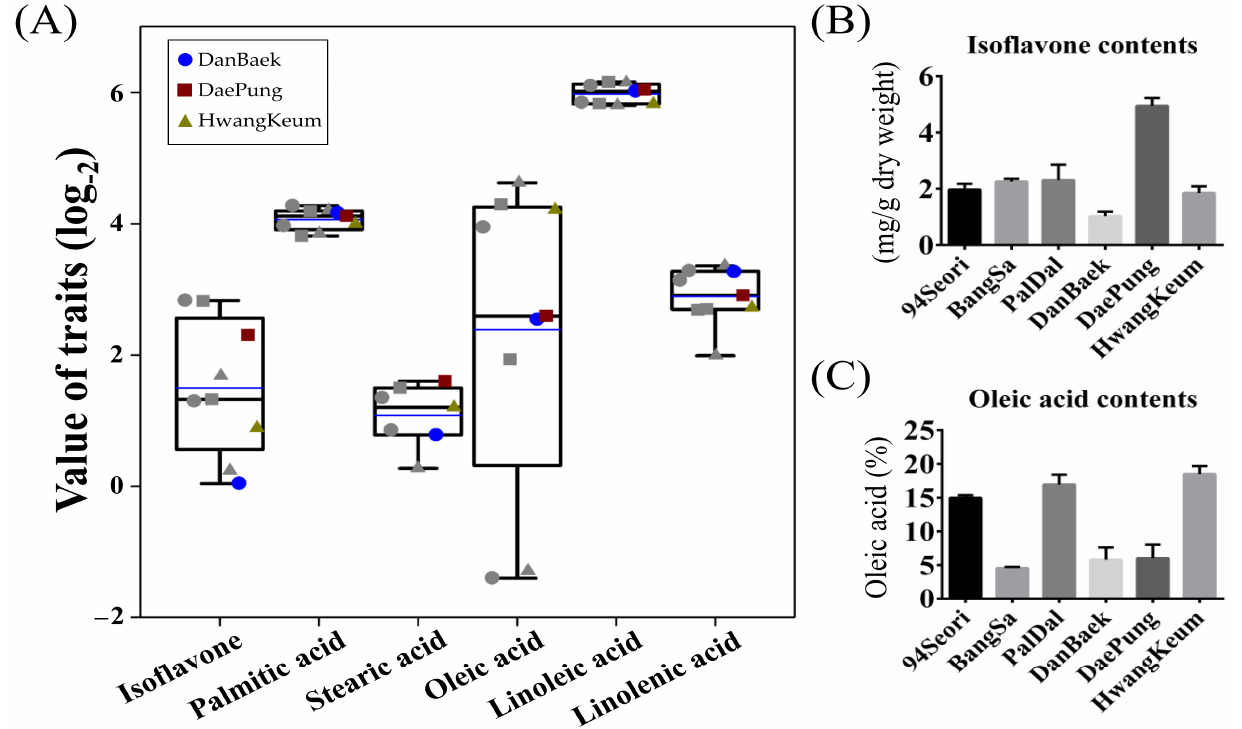
Figure 1. Changes in phytochemical traits (isoflavone and fatty acid contents) of 15 selected MDP lines compared with six Korean cultivars of soybean. ( A ) Box plots of the phenotypic distributions for three wild-type cultivars and their selected MDP lines (six isoflavone-altered lines comprising DB-088, DB-064, DP-084, DP-093, HK-17, and HK25-165; and six oleic acid-altered lines comprising DB-075, DB-041, DP-056, DP-184, HK-30, and HK-37; represented by gray symbols). The data are presented as log 2 -based mean values for individual lines. Distribution of the phytochemical traits among the six Korean cultivars is presented for ( B ) isoflavone (mg/g dry weight) and ( C ) oleic acid (%) contents. Table 1. Variation of isoflavone contents (mg/g dry weight) in seeds of 208 soybean MDP lines.